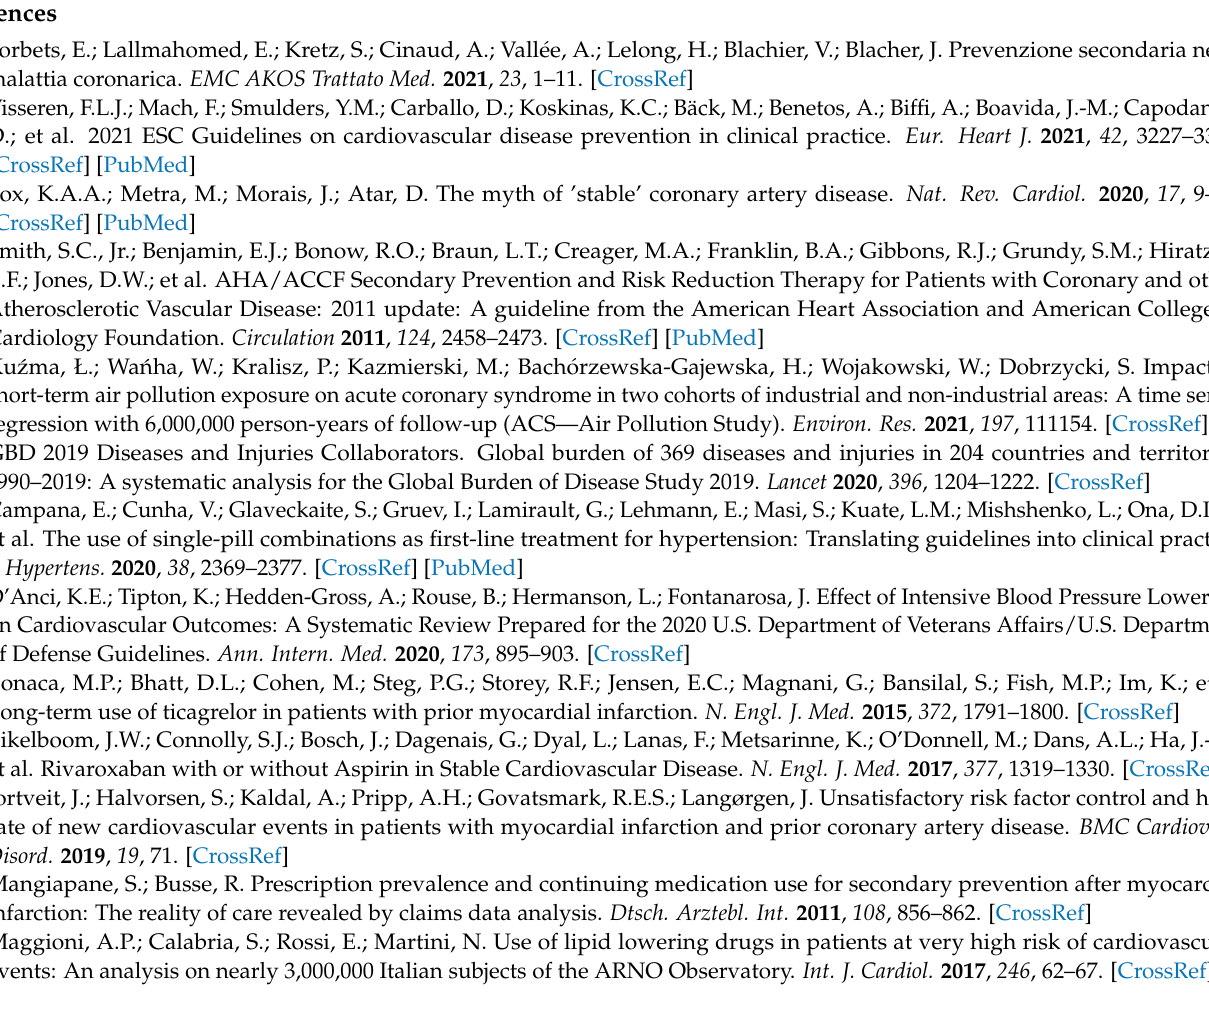
Table S5: “Hospitalizations of patients with CAD and eligible for cardiovascular (CV) secondary prevention drugs during the follow-up